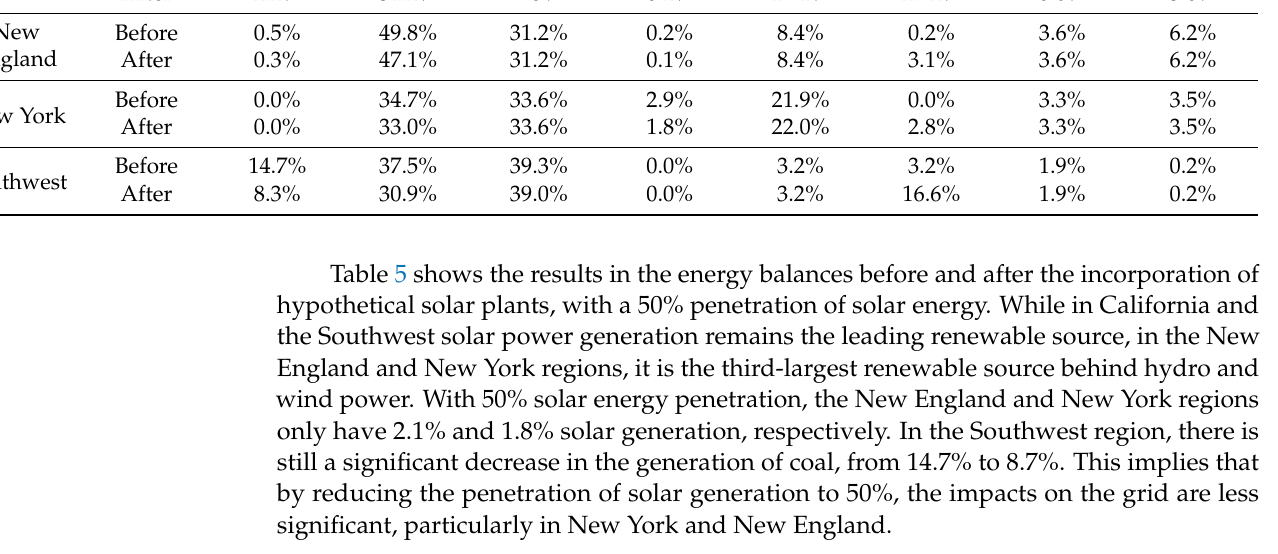
Table 5. 50% solar penetration—Generation by region and sources before and after adding the hypothetical solar